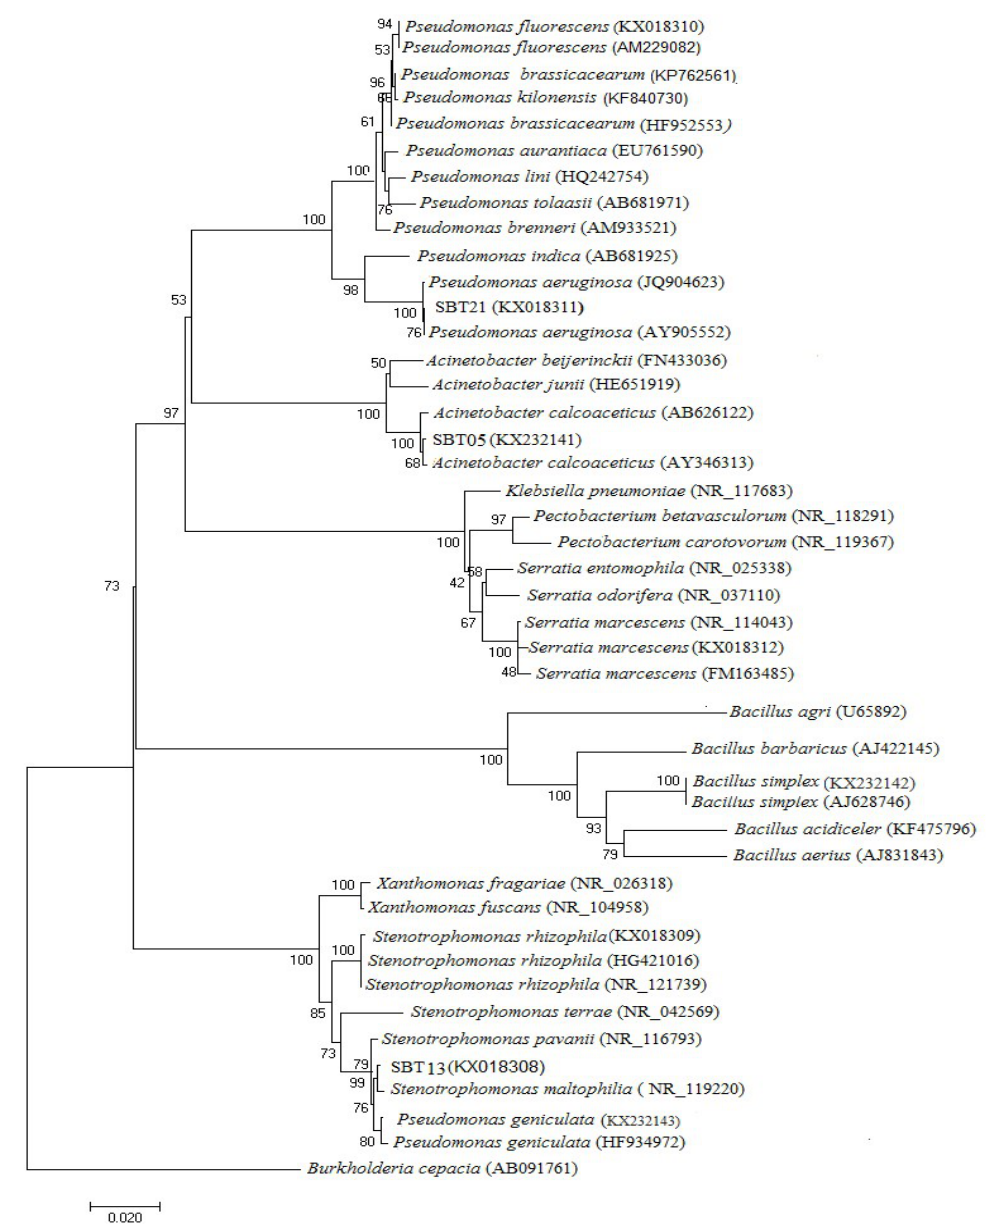
Fig. 5. Phylogenetic analysis of SBT05, SBT13 and SBT21 and related species based on neighbor-joining tree and sequence data from 16s rRNA gene: The value on each branch is the percentage of bootstrap replications supporting the branch. The GenBank accession number for each microorganism used in the analysis is shown in parentheses after the species